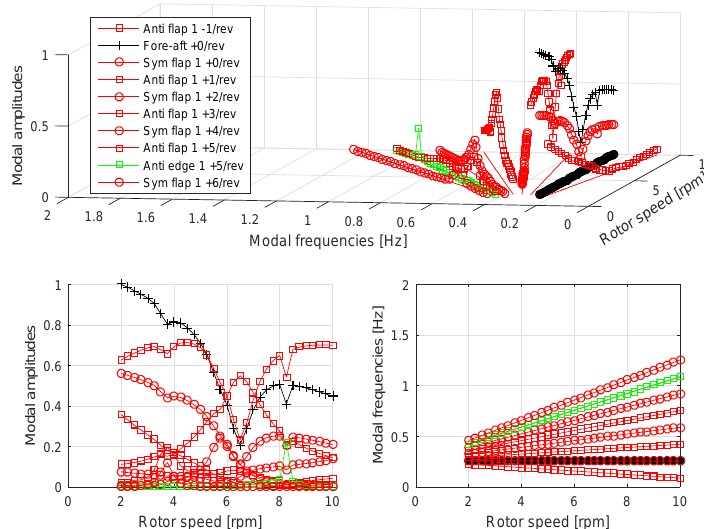
Figure 16. Harmonic modal components for the two-bladed turbine mode dominated by tower fore–aft motion. Plot layout as in Fig. 5.